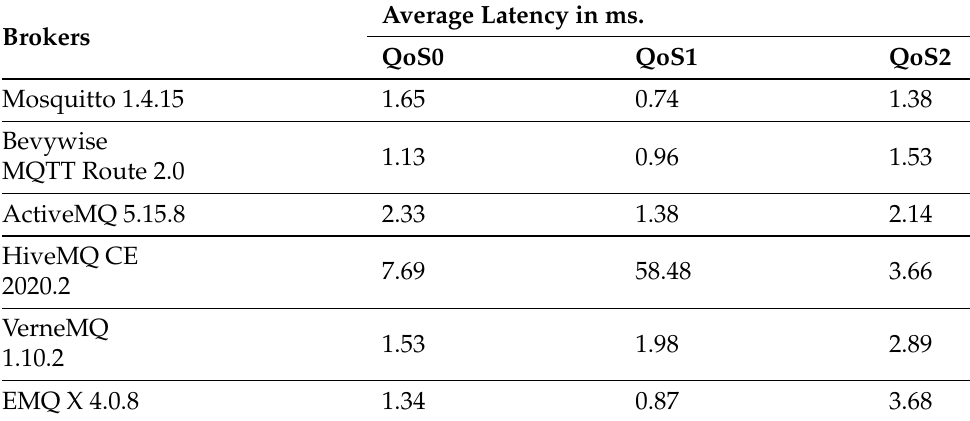
Table 10. Latency comparison of all the brokers in local test environment.